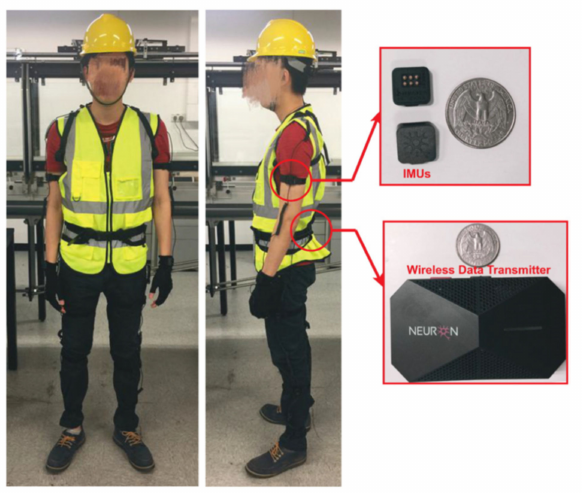
Figure 7. IMU-based wearable motion capture system (Perception Neuron) [111].